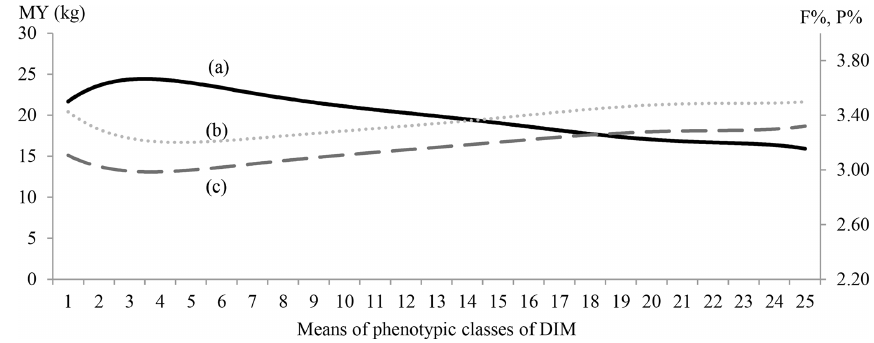
Figure 1. MY (continuous line; a ), F% (dotted line; b ) and P% (dashed line; c ) by 25 classes of days in milk (DIMs).